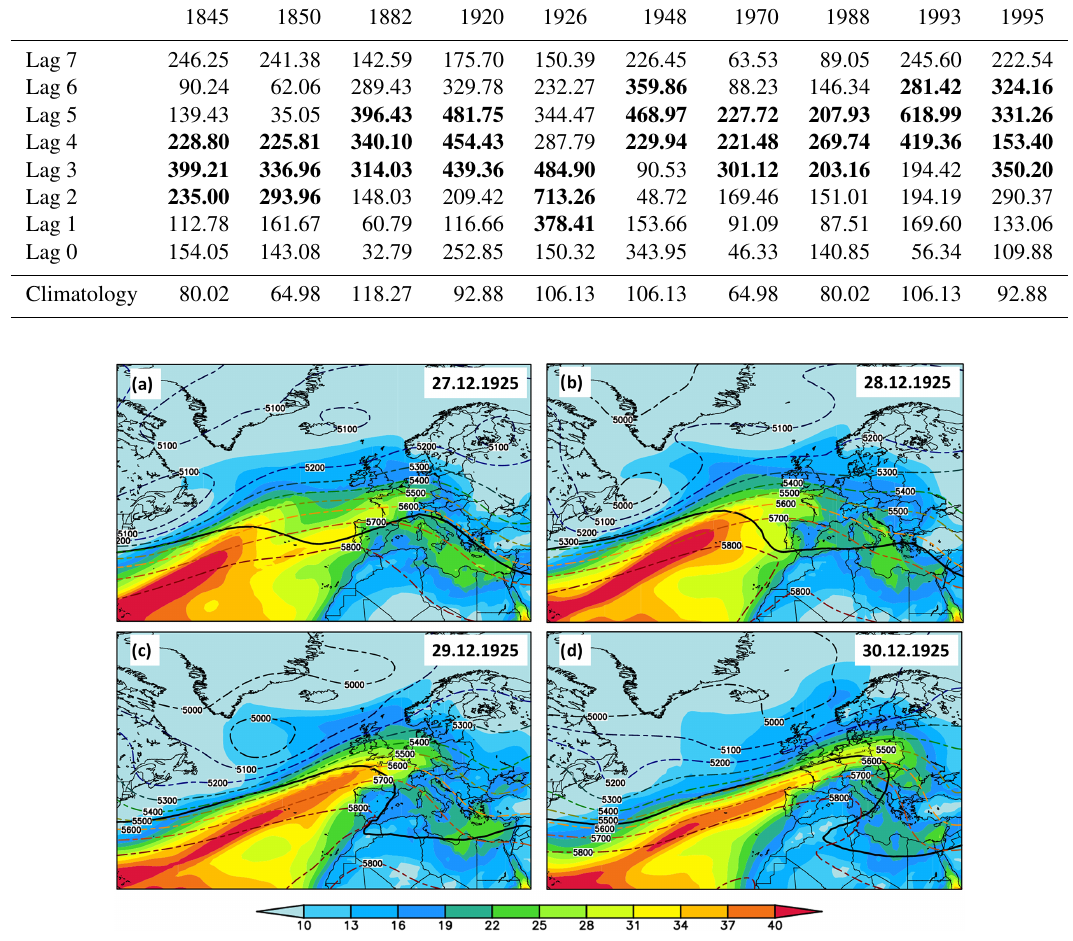
Figure 4. Daily integrated water vapor (IWV; shading) and daily geopotential height at 500hPa (Z500; contour lines) for (a) 27 Decem- contour at 330K. Units: IWV (kgm − 2 ) and Z500